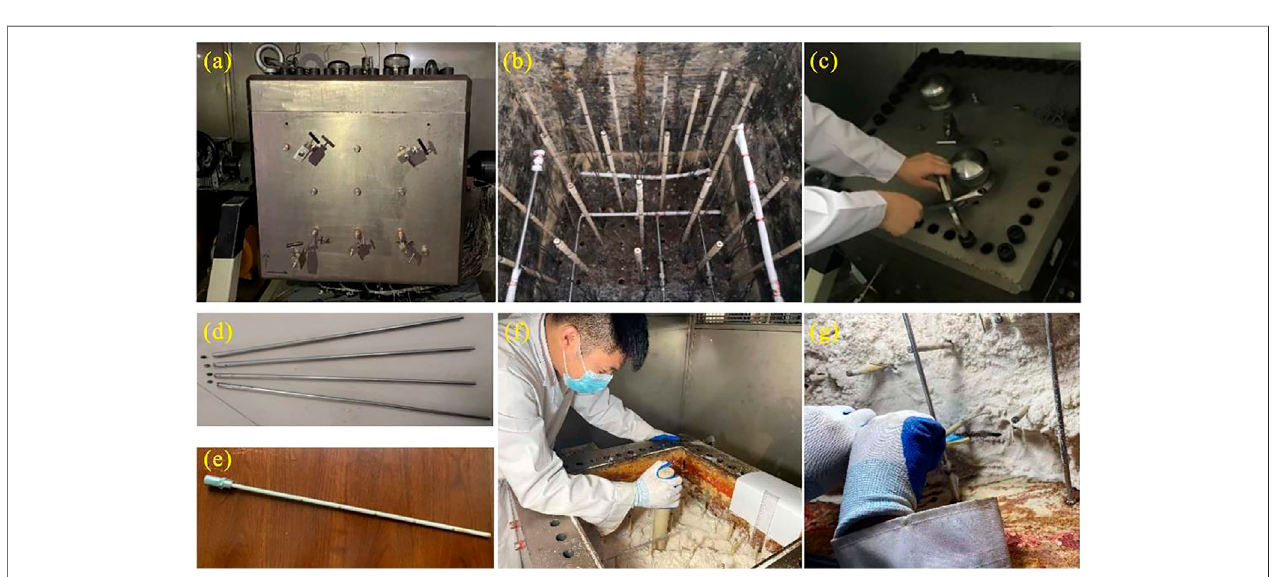
FIGURE 2 | Physical simulation equipment for water control processes. (A) kettle body; (B) measuring points and laying inside the equipment; (C) kettle body sealing; (D) sieve tube; (E) measuring points; (F) sand compaction in sections; (G) sand sampling.